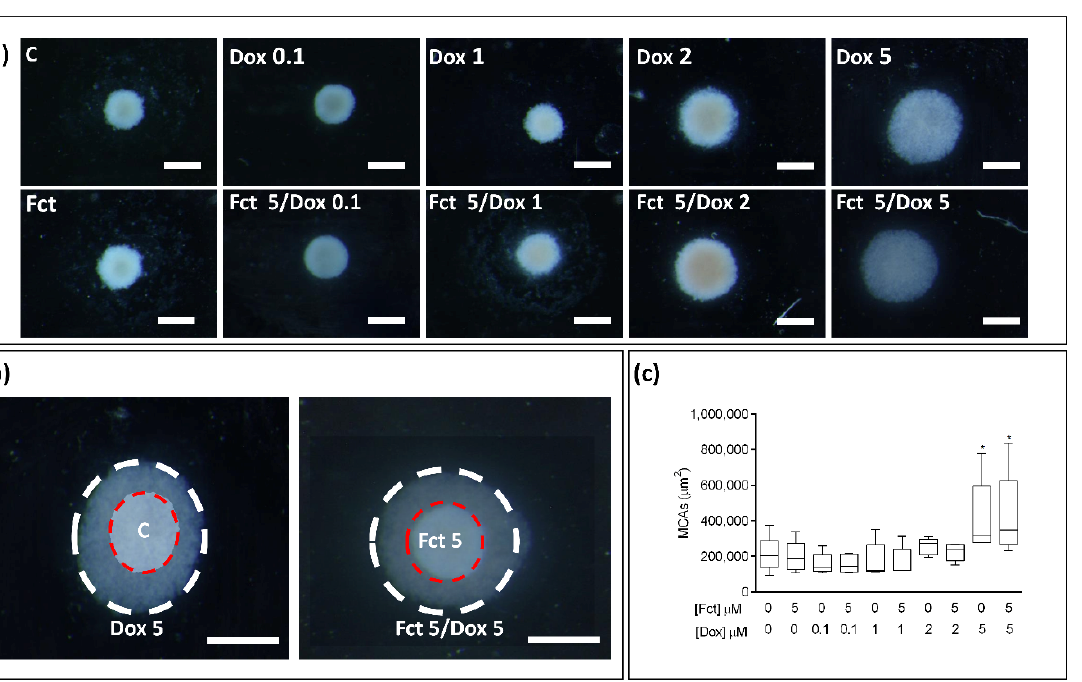
Figure 10. Effect of fucosterol (Fct) at 5 μ M alone and in combination with doxorubicin (Dox) at 0.1, 1, 2, and 5 μ M, on cell proliferation in monolayer–72 h ( a ) and 3D–96 h ( b ) assessed by BrdU assay. Cells treated with 0.1% DMSO and Dox 5 μ M were included as negative and positive controls, respectively. The percentages of cell proliferation are relative to the control and presented as mean + standard deviation of five independent experiments (each in triplicate). (* p < 0.05, ** p < 0.01; *** p < 0.001; **** p < 0.0001).